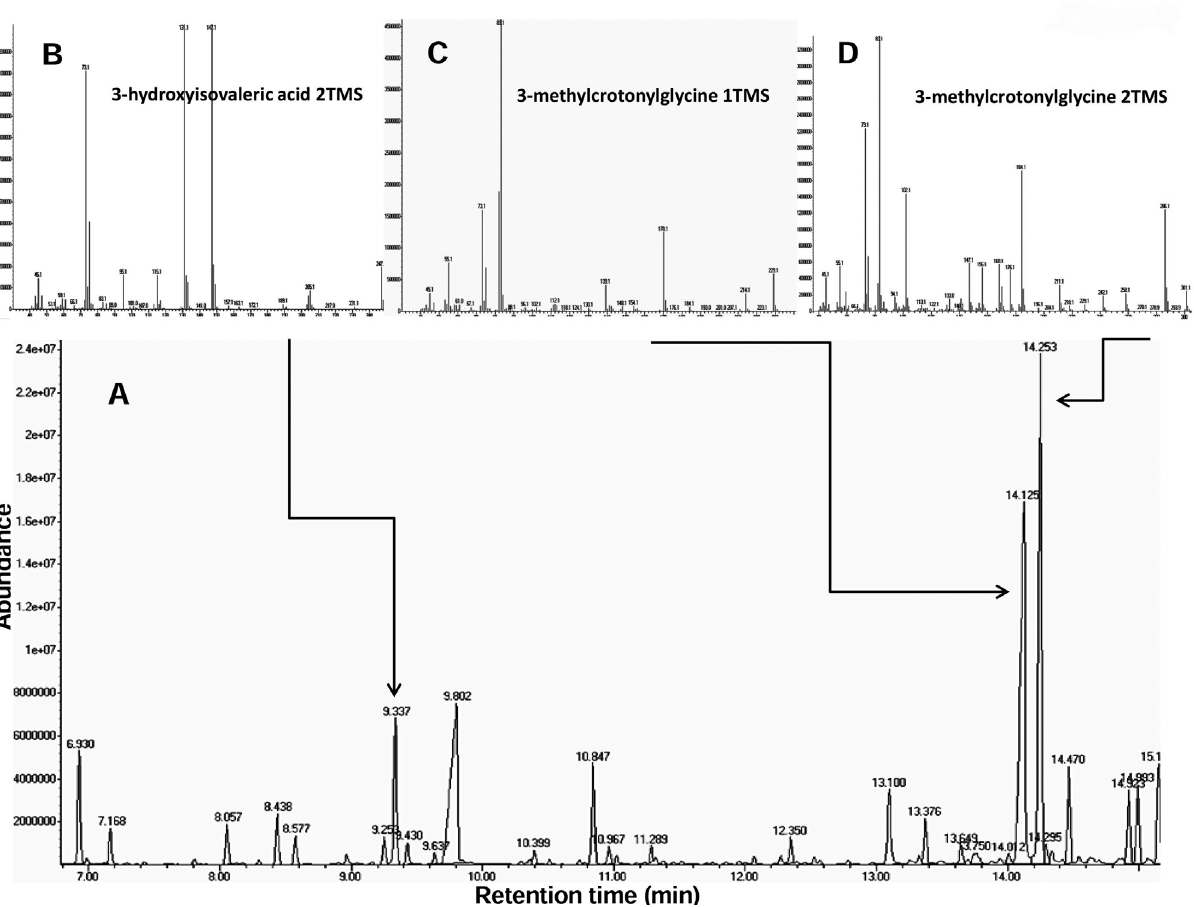
Figure 2 - Patient’s urinary organic acids profile. (A) Partial organic acids profile from urine; arrows point to the main altered metabolites; (B-D) mass spectra for these organic acids. 1TMS and 2TMS refer to the presence of 1 or 2 trimethylsylil ester groups, respectively, added during the derivatization